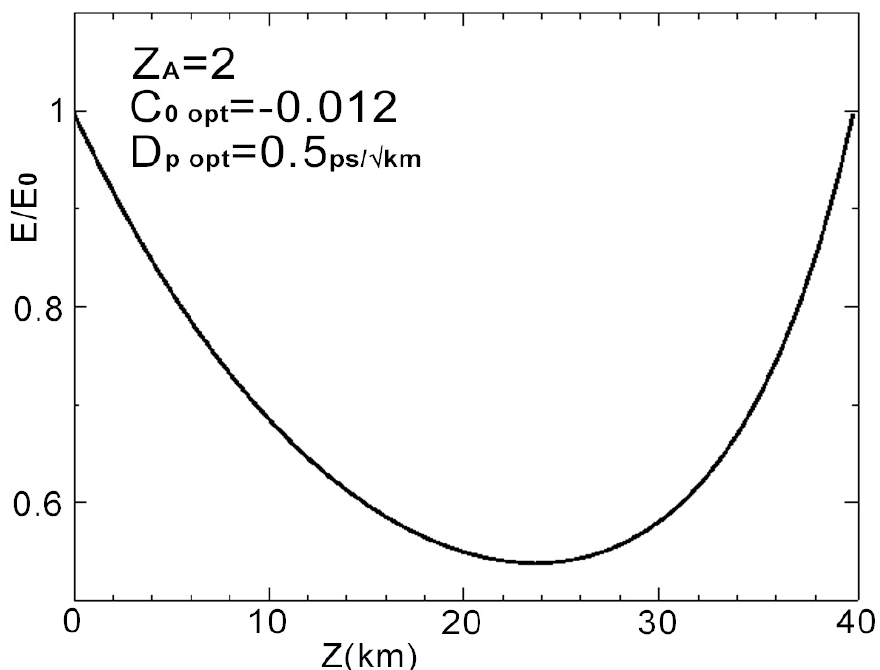
Figure 4. Evolution of the energy for the solitonic vectorial pulse with z A = 2 in one amplification stage in optimal pump conditions P 0 opt , shared between the polarization components according to (55) and (56), with θ = π /4 and optimal chirp. The value for the polarization mode dispersion ( PMD ) parameter is D p = 0.5 ps · km − 1/2 .